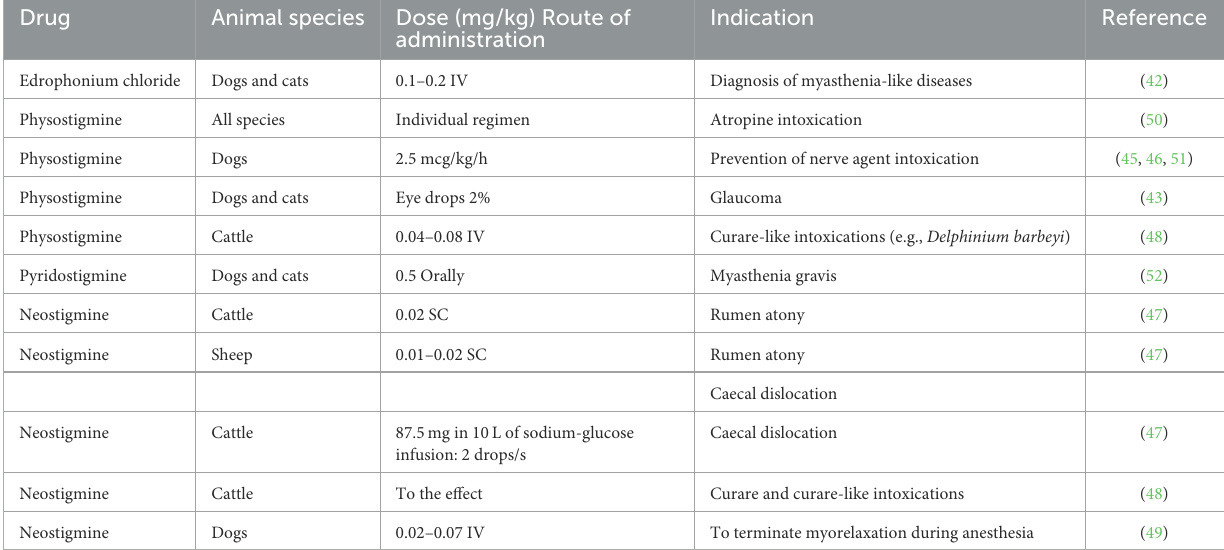
TABLE 2 Use of drugs that act as AChE inhibitors in